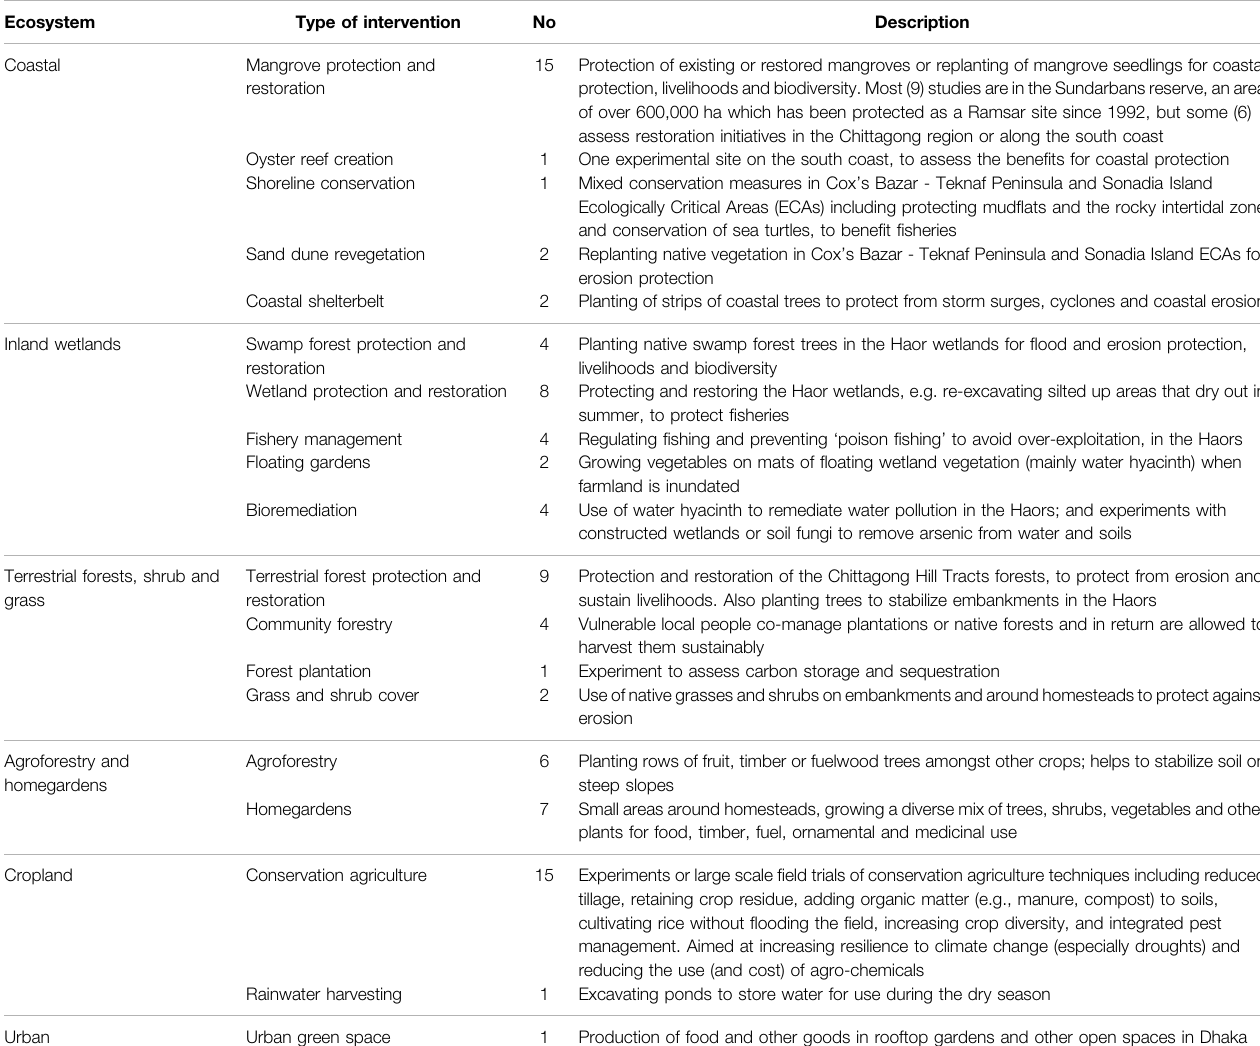
TABLE 3 | Main types of NbS intervention identi fi ed in the review for Bangladesh.